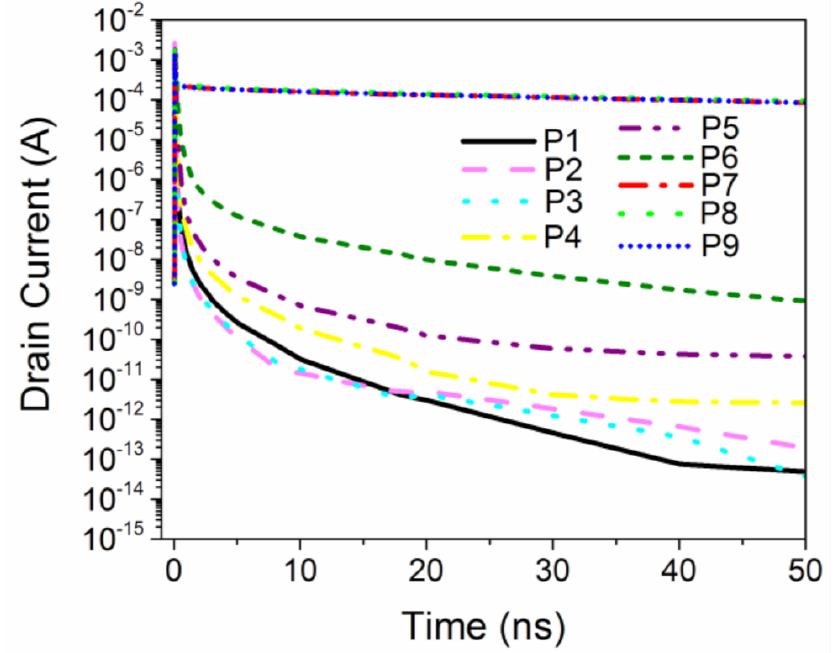
Figure 8. The transient drain currents after heavy-ion striking with different